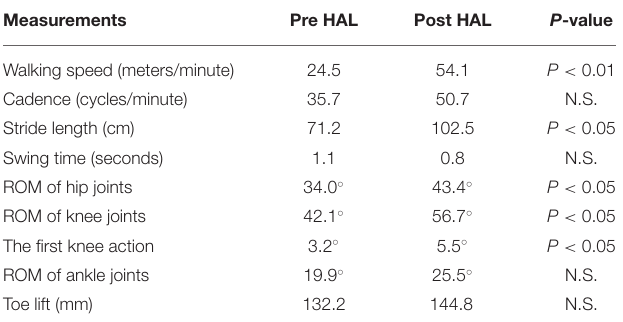
TABLE 2 | Comparison of gait kinematics between pre and post HAL intervention in acute stage patients. Measurements